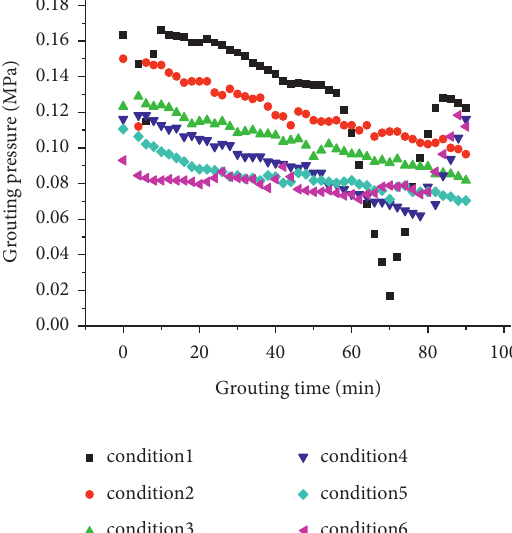
Figure 13: Case B1’s grouting pressure changes with time in the jacking return times. Note: data were read from each measuring point of the monitoring section every minute, and a total of 9 grouting pressure values were obtained. The weighted average value of 9 grouting pressure values is taken as the representative value of the grouting pressure of pipe jacking at this